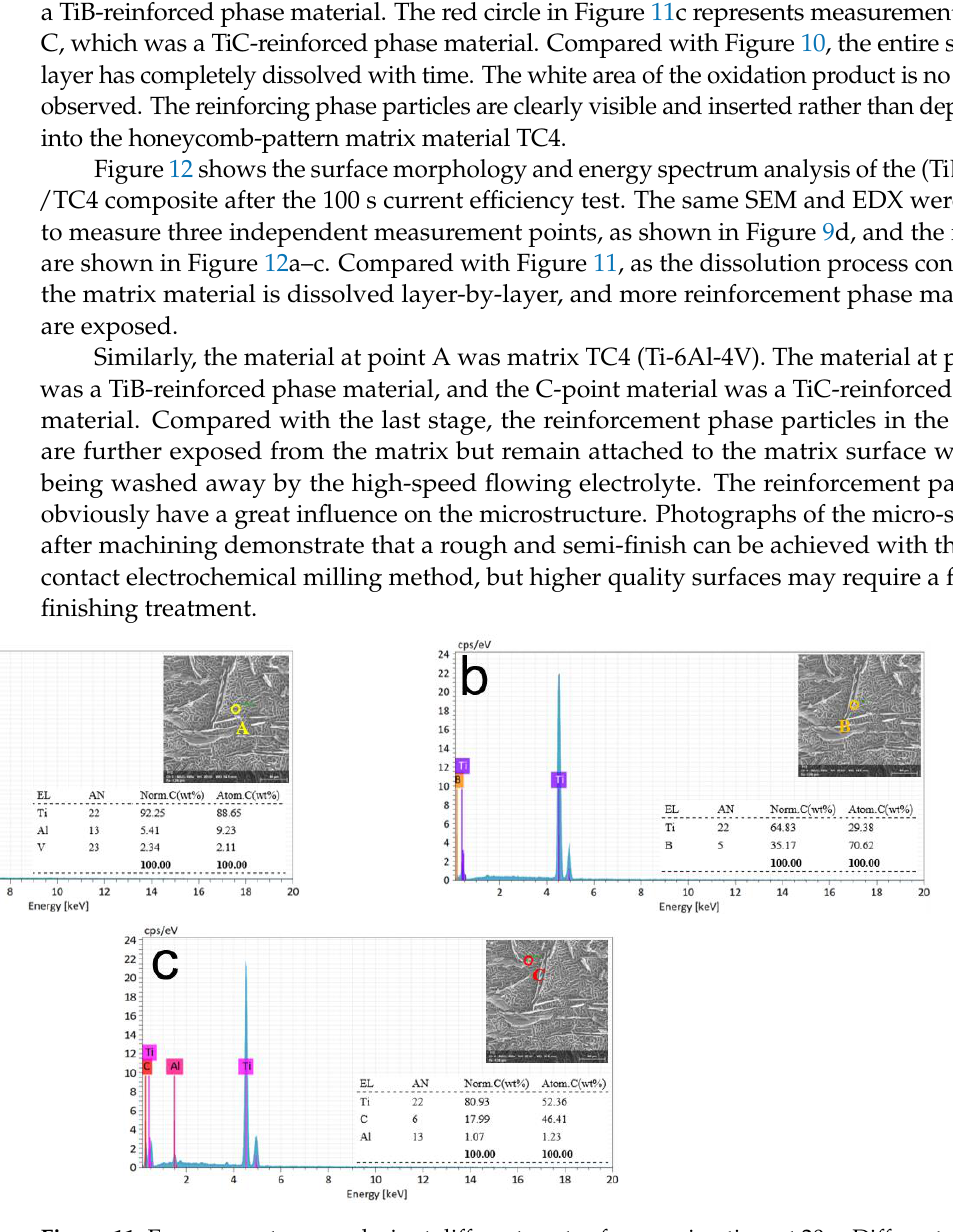
Figure 11. Energy spectrum analysis at different spots of processing time at 20 s. Different colored circles indicate measurement points at various locations. ( a ) Matrix material. ( b , c ) Reinforcing phase particles attached to the matrix.